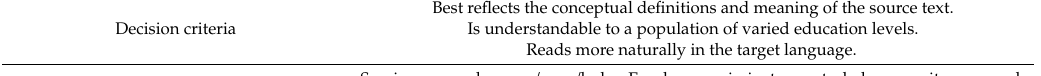
Best reflects the stress of the source text. Reads more naturally in the target language. Is semantically precise.